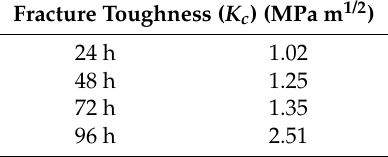
Table 8. Fracture toughness values of HA coating held in SBF for different periods of time